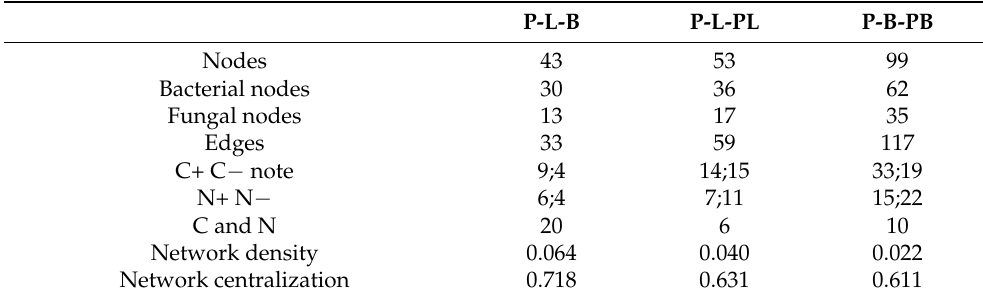
Table 1. Number of nodes and edges in bacterial and soil function network. +, represents positive correlation; − , represents negative